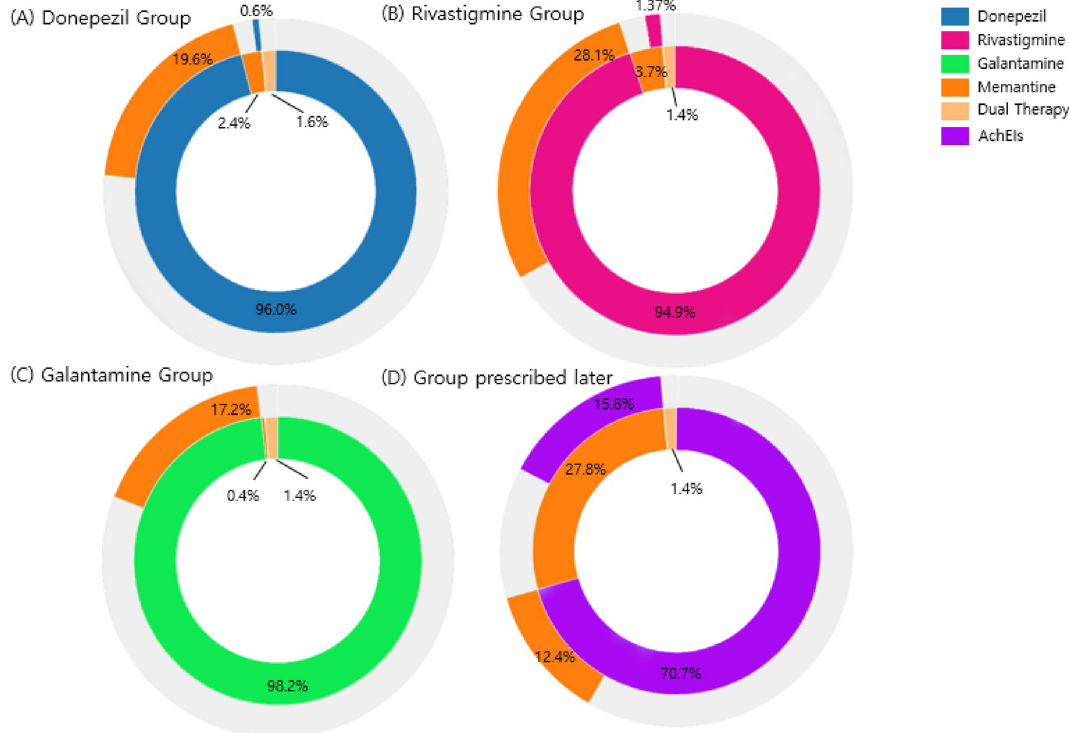
Figure 4. Treatment pathway of each choline esterase inhibitor (AChEI) group combined with NMDA receptor antagonist from all hospitals. For each choline esterase inhibitor group, Donepezil ( A ), rivastigmine ( B ), galantamine ( C ) and Group prescribed drugs at least 6 months later from initial diagnosis ( D ), the inner circle shows the first medication that the patient took, the second circle revealed the second